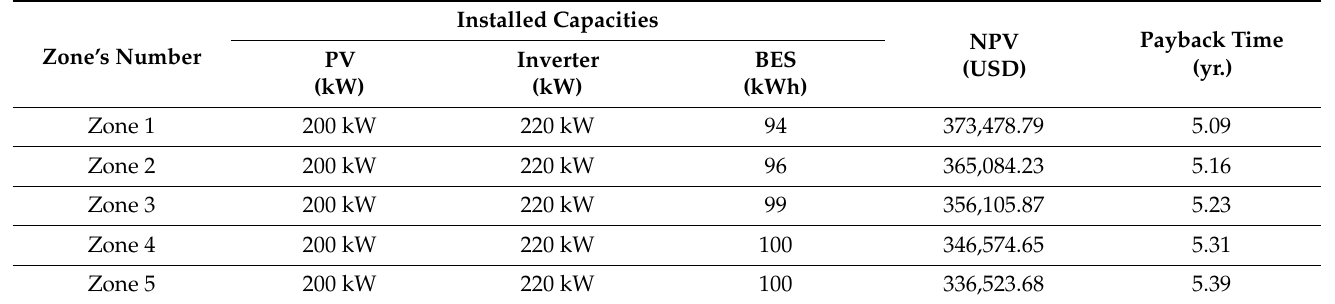
Table 7. The optimized capacity, the NPC, and the payback time of the system in case